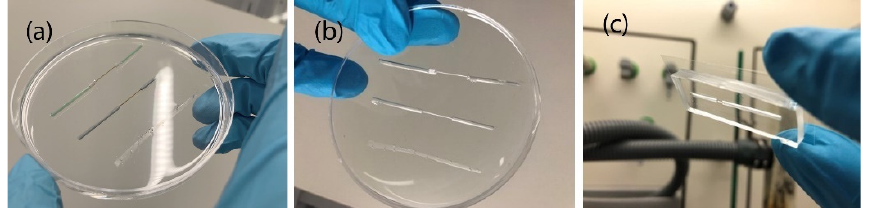
Figure 6. PDMS fabrication methods using capillaries and tape. ( a ) Capillaries and adhesive tape coated with PDMS. ( b ) Hardened PDMS with removed capillaries and adhesive tape. ( c ) Structured PDMS bonded to glass.